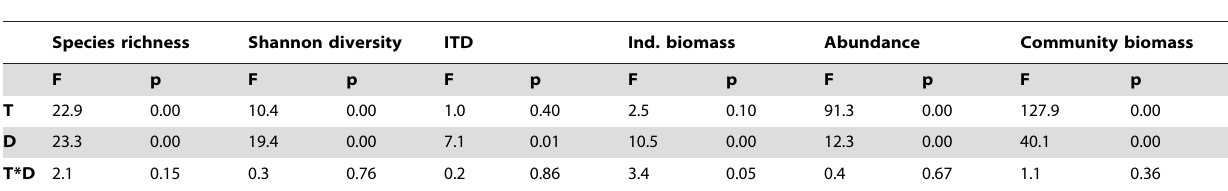
Table 5. F- and p-values of 2 6 3 factorial ANOVA (n=5).